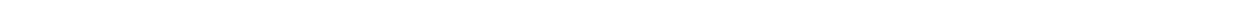
Fig. 2 Rab35 promotes progressive interface contraction required for cell intercalation. a , b Still frames of embryos expressing a cell outline marker (Resille: GFP) injected with control dsRNA (Rhodopsin3, Rh3, a ) or Rab35 dsRNA ( b ). In control-injected embryo, the AP interface ( yellow line ) has fully contracted after 5 min. b In the Rab35 knockdown embryo, the AP interface ( yellow line ) undergoes an initial contraction ( middle panel ) but reverses itself. After 5 min the interface shows no net contraction ( right panel ). c , d Frequency of n -sided cells during germband extension in control Rh3 dsRNA and Rab35 dsRNA embryos ( n = 74 and 83 cells, respectively). Germband extension initiates as a primarily hexagonal lattice in both control and Rab35 dsRNA embryos. In control embryos, the number of six-sided cells rapidly decreases, while the number of alternatively sided cells increases as convergent extension movements occur. In Rab35 dsRNA embryos, there is a slight initial decrease in hexagonal cell number, before cell topologies return to the initial con fi guration. e – g Rab35 dsRNA embryos have a decrease in productive interface contractions with reduced MSDs ( e ) and a near absence of the active MSD component ( f ) and decreased diffusive component ( g ). n = 286 (control) and 139 (Rab35 dsRNA) cells. h , i Oscillations in apical area still occur in Rab35 dsRNA embryos ( h ), with an amplitude similar to control Rh3 dsRNA-injected embryos ( i ). n = 631 (control) and 340 (Rab35 dsRNA) cells. Student ’ s t -test, *** P < 0.0005. Error bars indicate standard error. Scale bar is 2.5